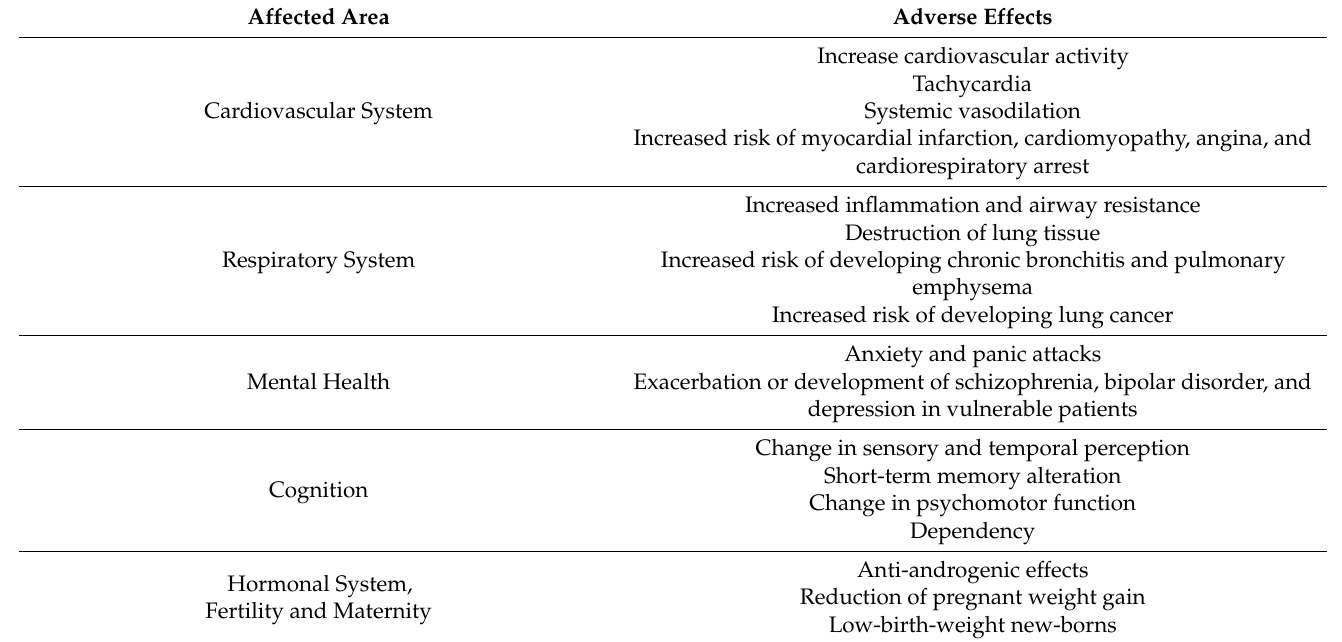
Table 4. Adverse effects of